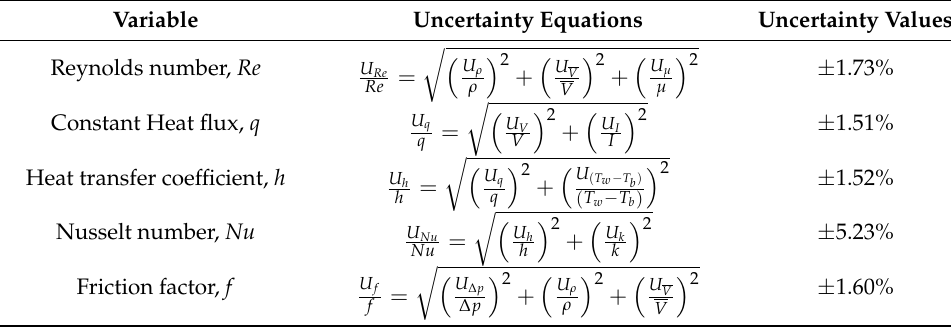
Table 1. Uncertainty ranges for heat transfer and fluid flow